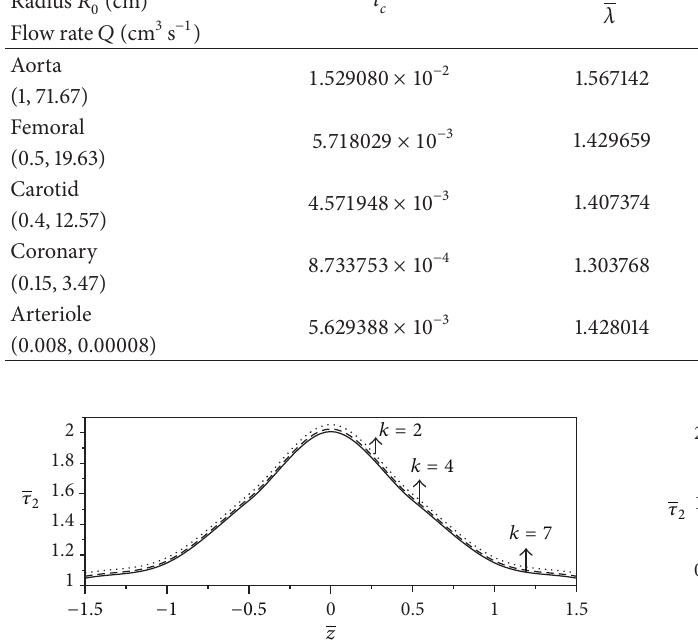
Table 2: Estimates of resistance to flow 𝜆 2 and skin friction (dimensionless) 𝜏 2 in arteries with different radii with 𝐿 0 /𝐿 = 1 . Blood vessels